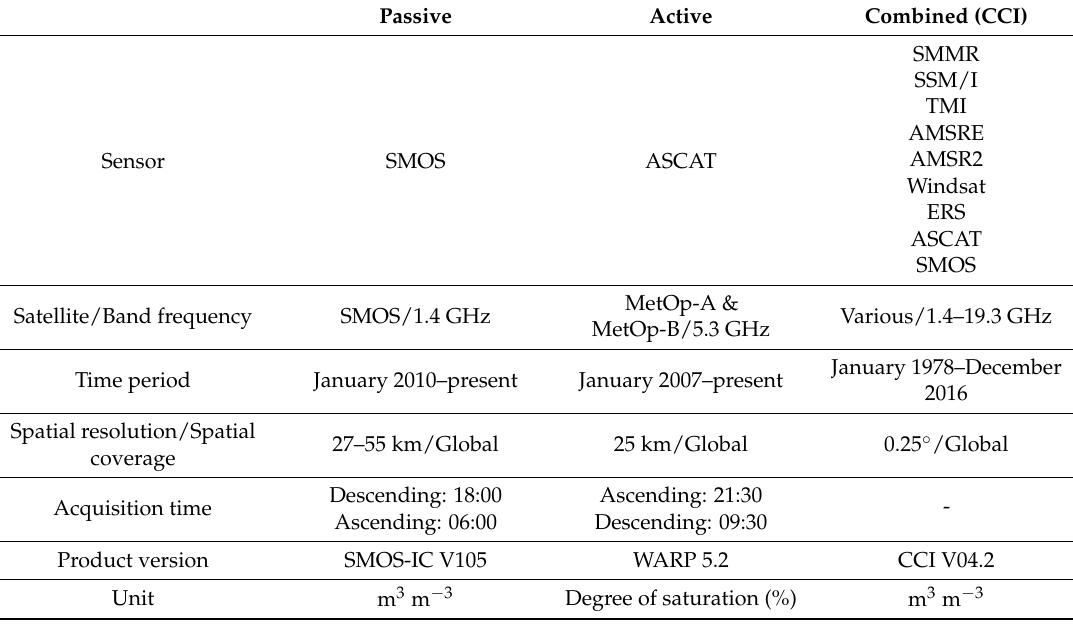
Table 4 . An overview of the remotely-sensed soil moisture retrievals used in this study. Table 4. An overview of the remotely-sensed soil moisture retrievals used in this